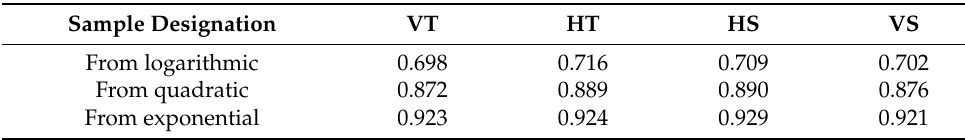
Table 3. Values of R taken from regression